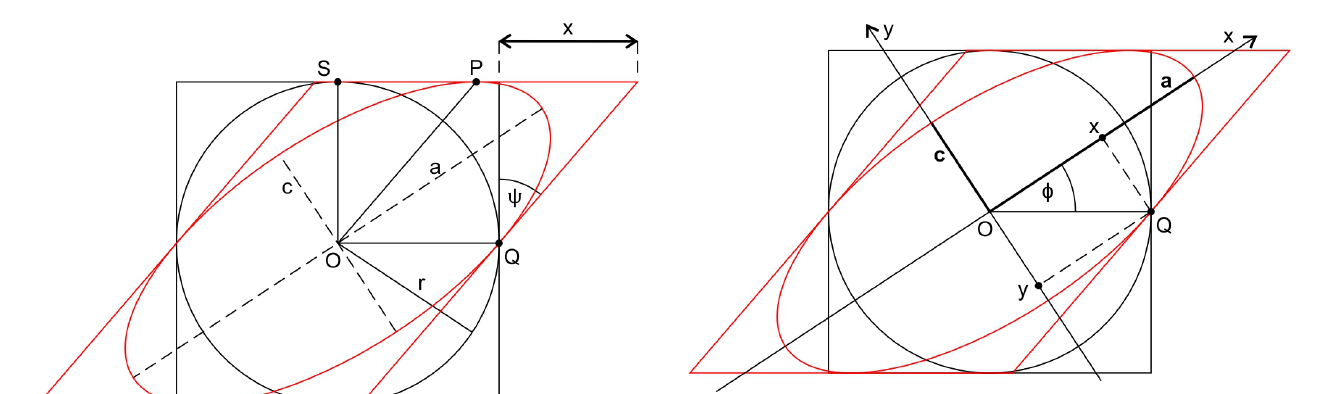
Figure A3. Deformation of a circle inscribed in a square into an ellipse inscribed in a parallelogram (red).